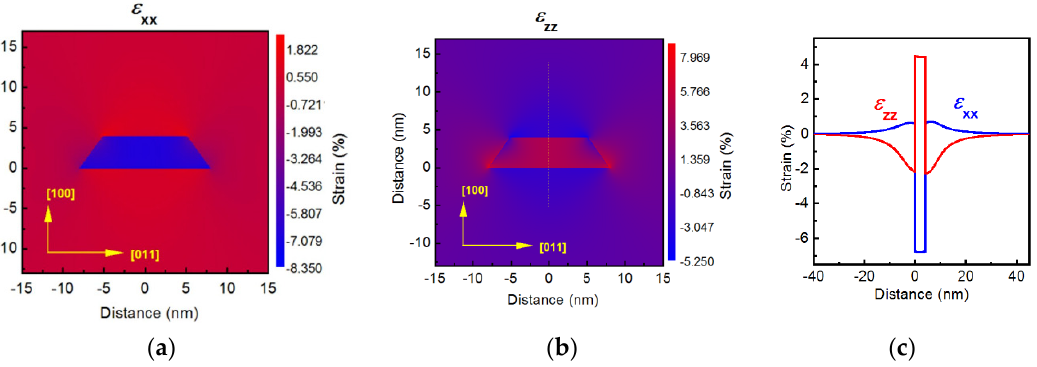
Figure 9. Strain distributions calculated for GaSb 0 . 65 P 0 . 35 /AlP SAQD with the height of 4 nm: ( a ) 2D map of ε xx component, ( b ) 2D map of ε zz component and ( c ) ε xx and ε zz trends along the central vertical SAQD axis marked by a thin yellow dashed line in panel ( b ).